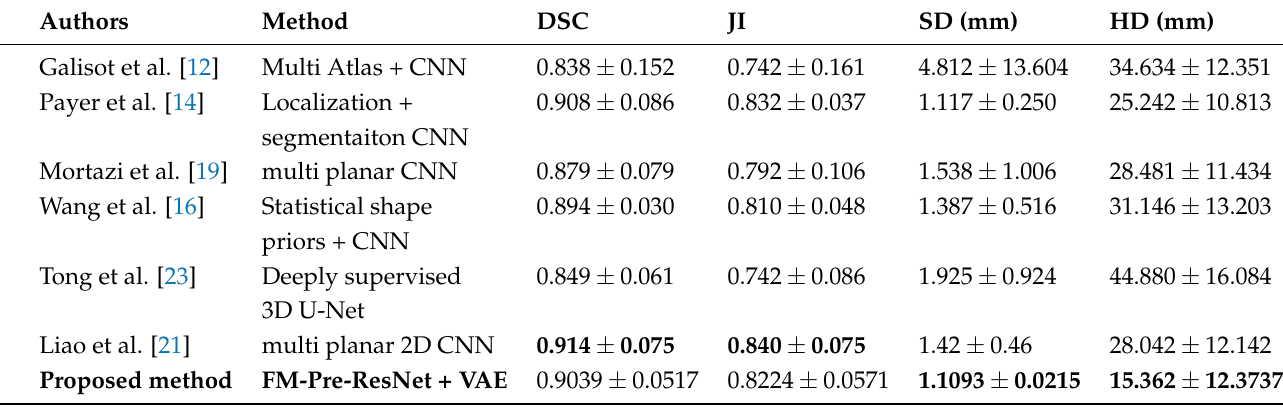
Table 6. Comparison of an average DSC, JI, SD, and HD of the state-of-the-art whole heart segmentation methods on CT images.